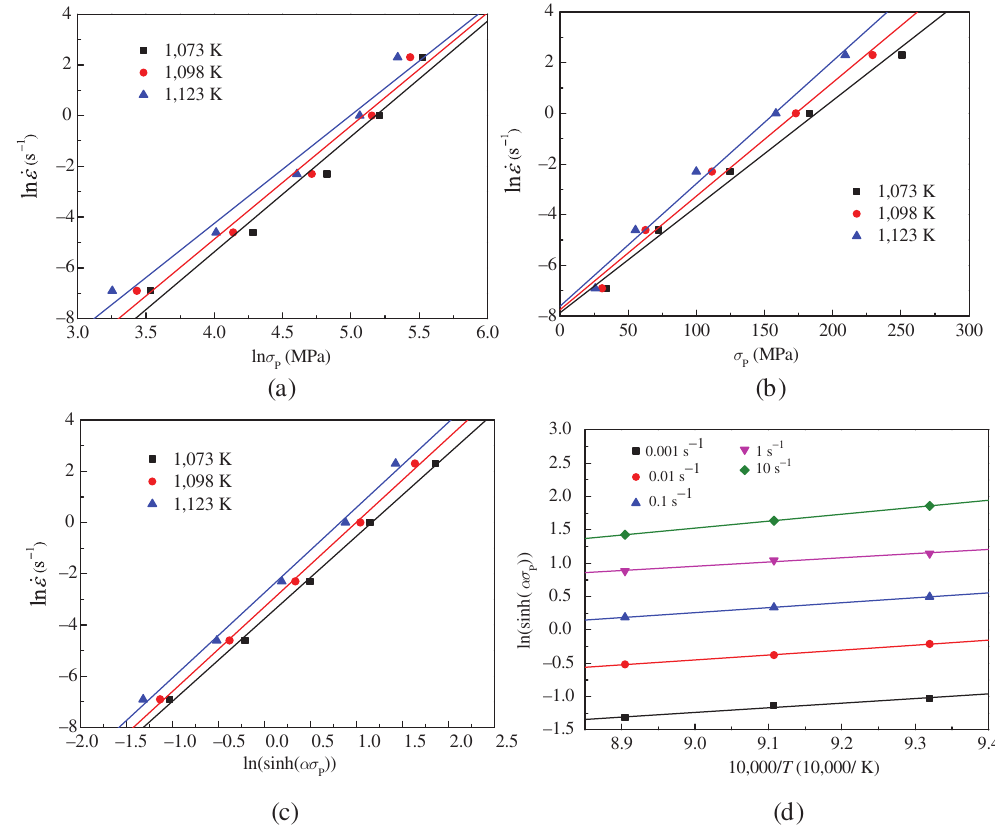
Figure 4 Relationship between (a) ln _ " (cid:5) ln σ P , (b) ln _ " (cid:5) σ P , (c) ln _ " (cid:5) ln ð sinh ð ασ P ÞÞ , (d) ln ð sinh ð ασ P ÞÞ (cid:5) 10 ; 000 = T in β -phase temperature range